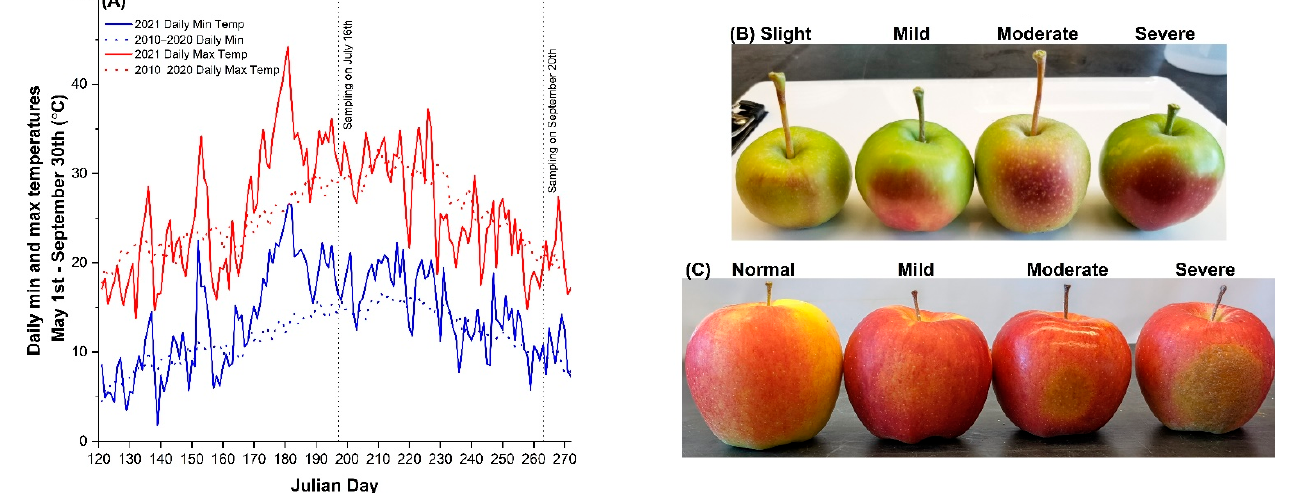
Figure 1. Sunburn browning (SB) of ‘Ambrosia’ apple due to sustained heat in the summer of 2021 at the Summerland experimental farm, the Okanagan Valley, British Columbia, Canada: ( A ) the daily maximum and minimum air temperatures in May to September of 2021 and 2010–2020 average; ( B ) the severity of sunburn browning symptoms in ‘Ambrosia’ apple fruit sampled on 16 July (Julian Day 197); ( C ) the progression of SB symptoms in mature apples sampled on 20 September (Julian Day 263).